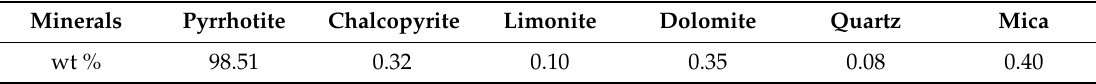
Table 3. Minerals compositions of pure pyrrhotite.